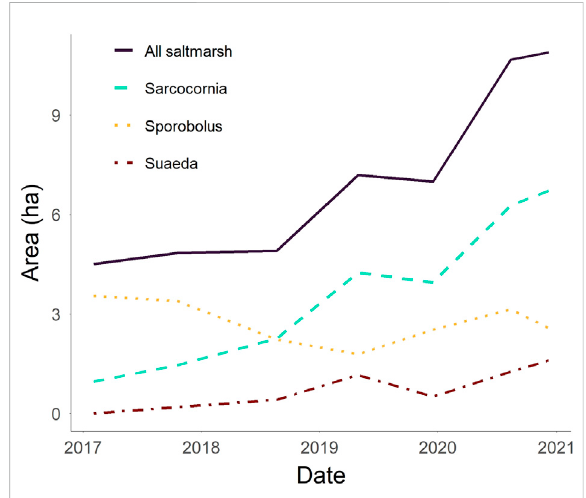
FIGURE 3 Change in saltmarsh area over time post rehabilitation at the study site. Areas were calculated using 0.1 m resolution classi fi ed imageswith > 75%user ’ sandproducer ’ saccuracyforeachspecies Supplementary Figure S4, Supplementary Figure S5).